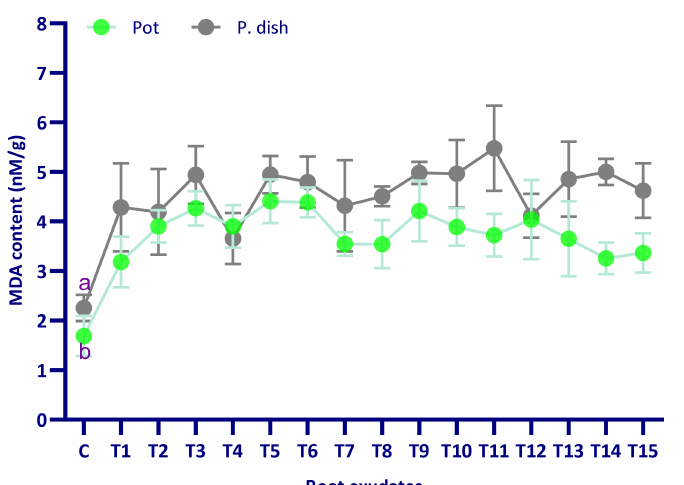
Figure 6. Malondialdehyde (MDA) contents of 10 days old seedlings of T. astivum in Petri dishes and pot conditions after irrigation with 15 weeds root exudates of 1 mL and 5 mL, respectively. The letters “a” and “b” indicate the significant differences between Petri dishes and pot culture, respectively, at p < 0.05 levels with control. ns = not significant. C = Control, T1: Centella asiatica , T2: Rotala indica , T3: Solanum nigrum , T4: ommelina benghalensis , T5: Marsilea quadrifolia , T6: Ageratum conyzoides , T7: Cynodon dactylon, T8: Spilanthes acmella, T9: Heliotropium indicum, T10: Leucas aspera , T11: Phyllanthus niruri , T12: Sida acuta , T13: Mikania micrantha , T14: Polygonum hydropiper , T15: Physalis heterophylla